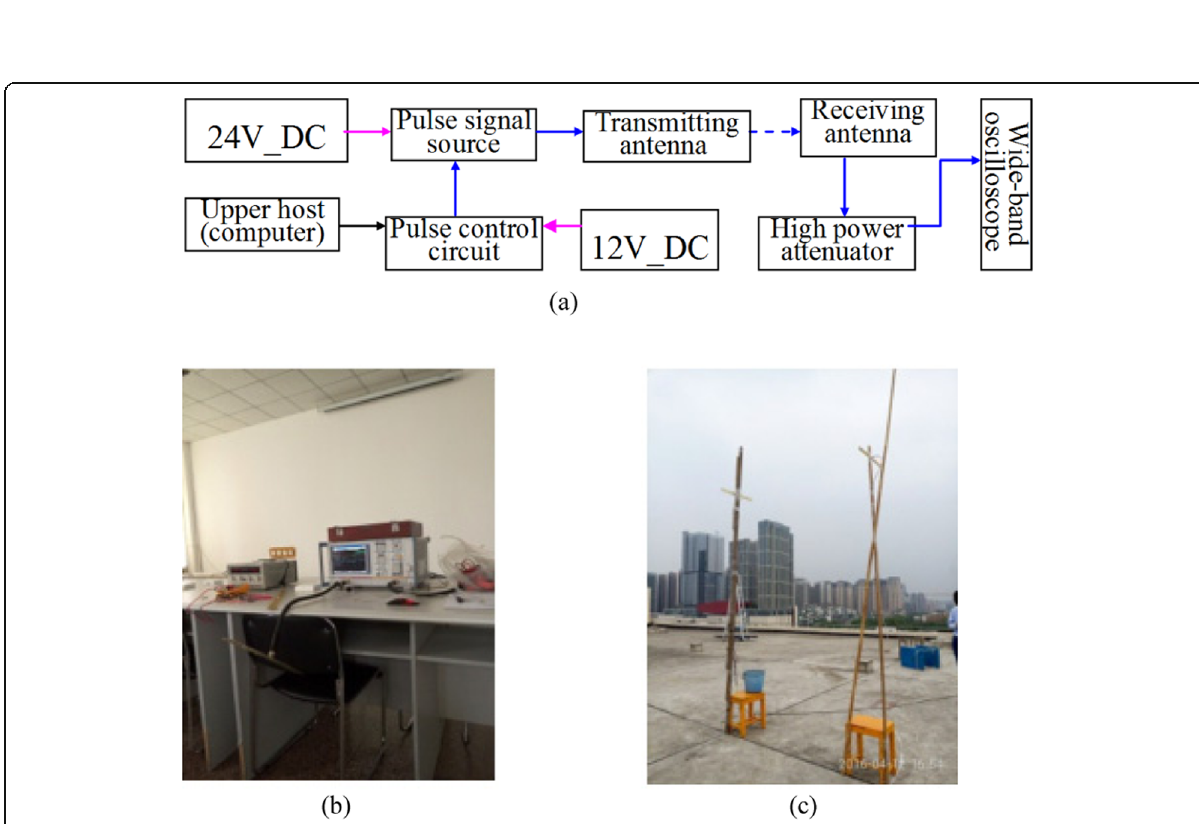
Fig. 6 Test circuit diagram and onsite photo of receiving antenna parameters. a Schematic diagram of time-domain parameters test circuit for receiving antenna. b Test photo of frequency-domain parameters. c Test photo of time-domain